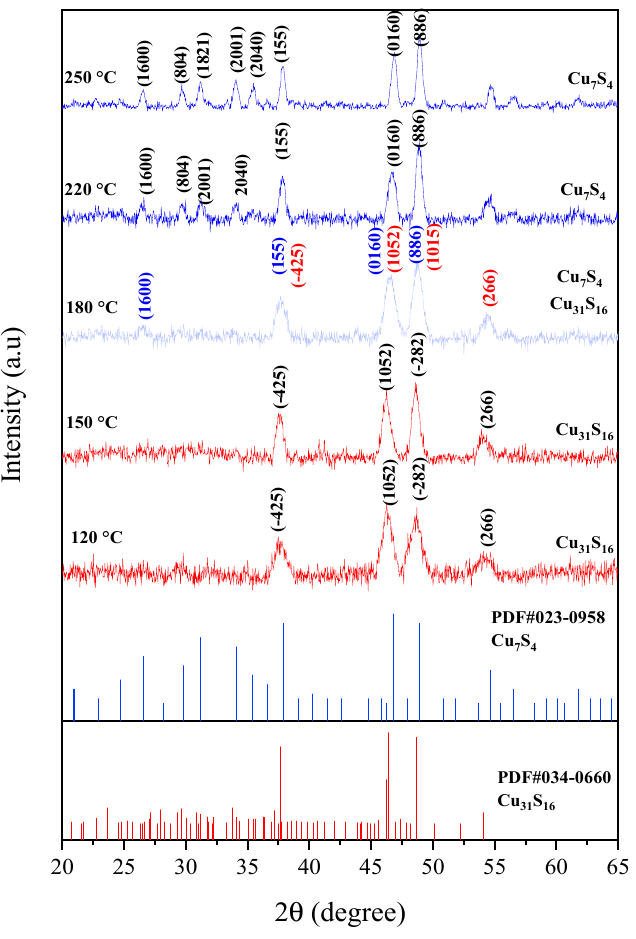
Figure 1. Overlapped XRD patterns for the various phases of copper sulfide obtained at different synthesis temperatures.